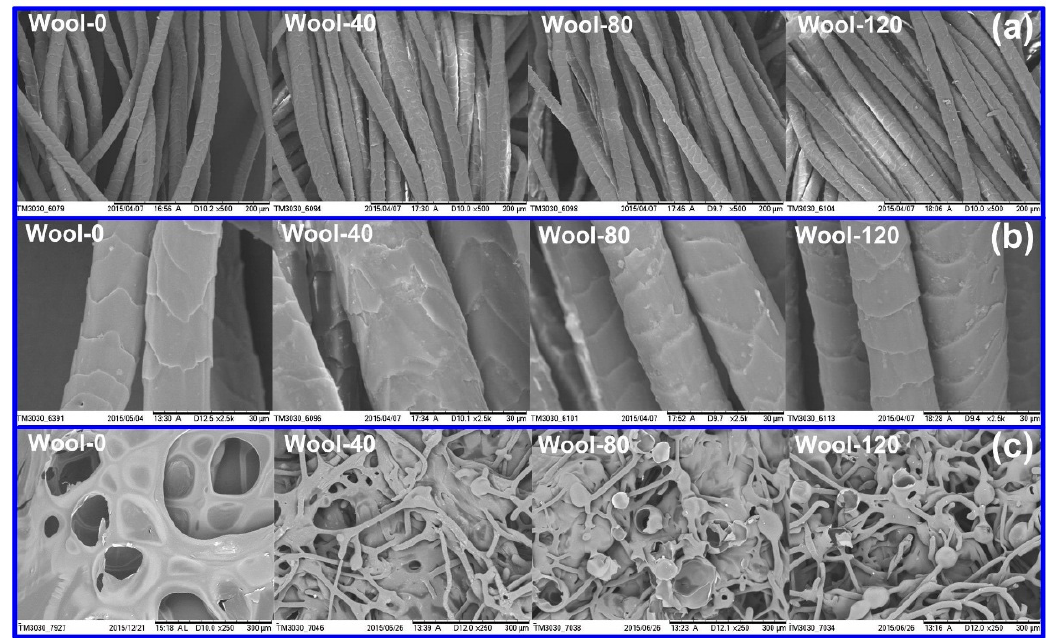
Figure 10. SEM micrographs of wool fibers ( a , b ) and char residues ( c ).